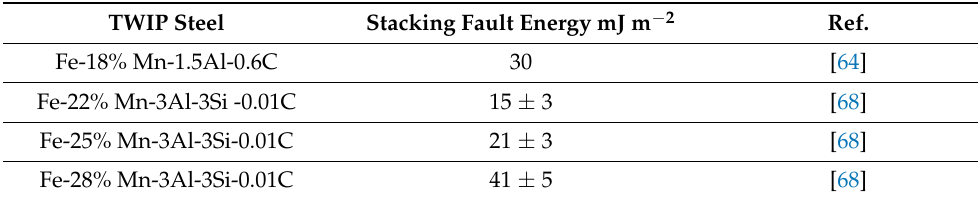
Table 1. Experimentally determined SFEs for some of the TWIP steels. TWIP